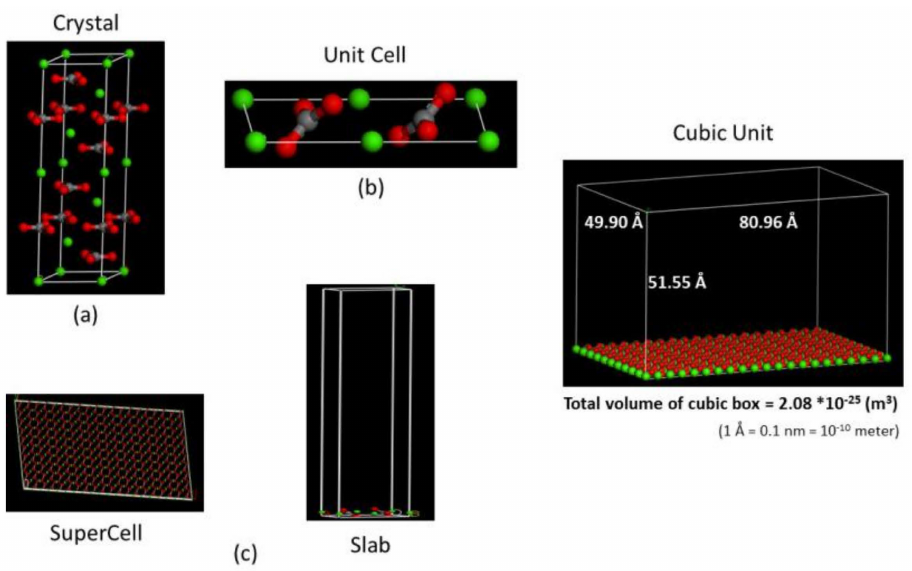
Figure 1. Construction of a calcite-based cubic cell. ( a ) The crystal structure of calcite. ( b ) The {10-14} surface of calcite is cleaved to generate a 2D unit cell. ( c ) A 10 × 10 supercell is created from the unit cell and expand to the slab high of 50